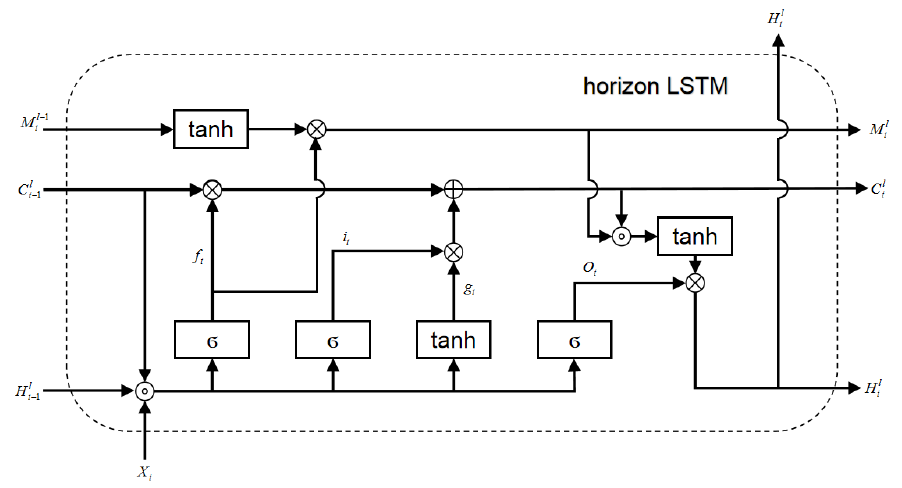
Figure 1. The architecture of Horizon LSTM, in which the temporal and spatiotemporal memories exist in overpass way through gate